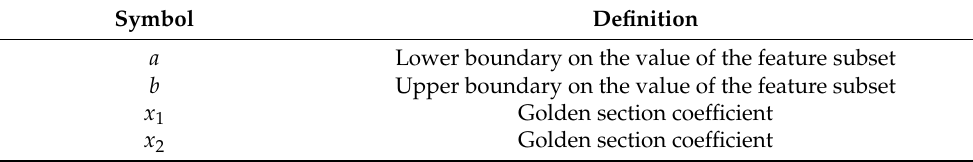
Table 1. Cont. Symbol Definition Lower boundary on the value of the feature subset